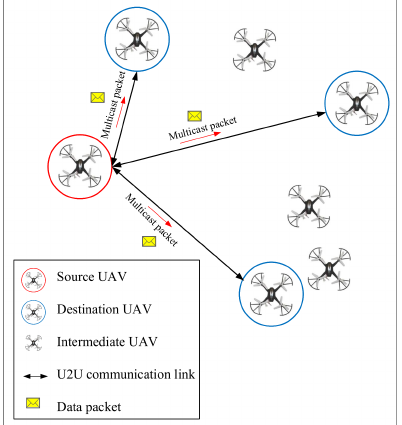
Figure 23. Multicast-based routing.